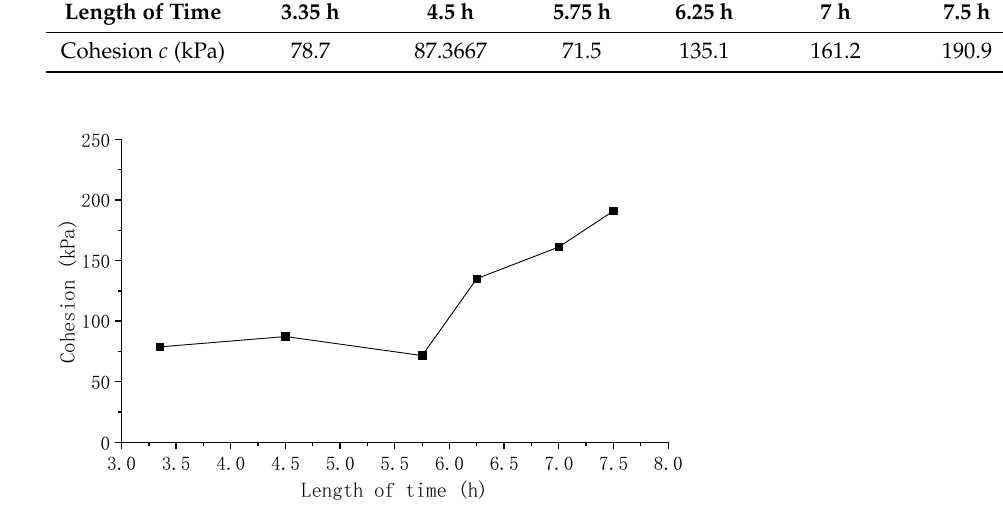
Figure 6. The changing trend of the valid cohesion–age data obtained by the proposed regression analysis.